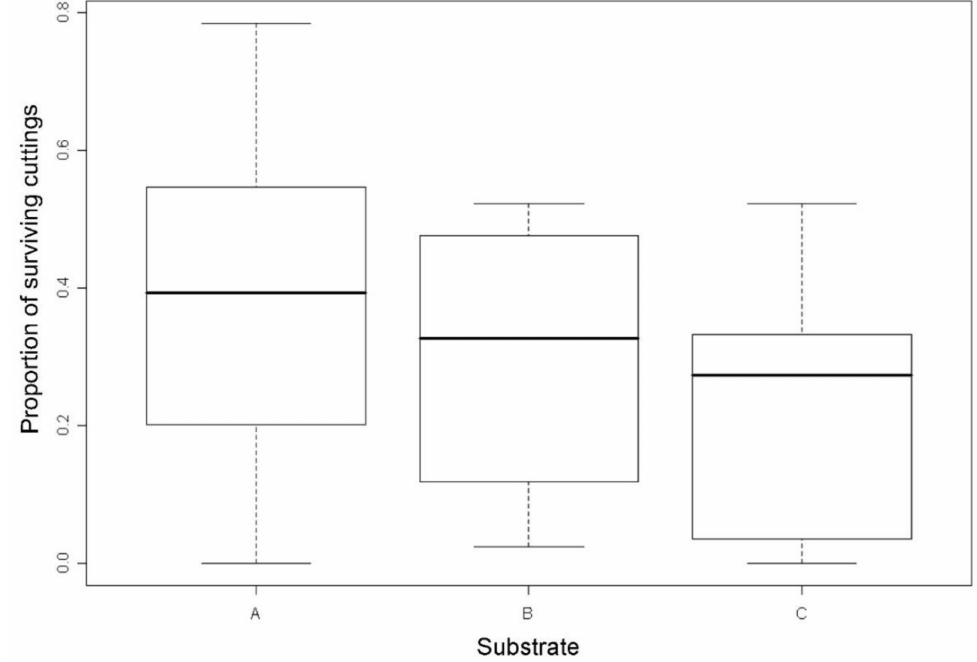
Figure 4. Box plot of the proportions of surviving cuttings from the total number of cuttings in relation to the substrate. The horizontal line in each box represents the median, the hinges represent the 25th and 75th percentiles and the whiskers represent 1.5 times the interquartile